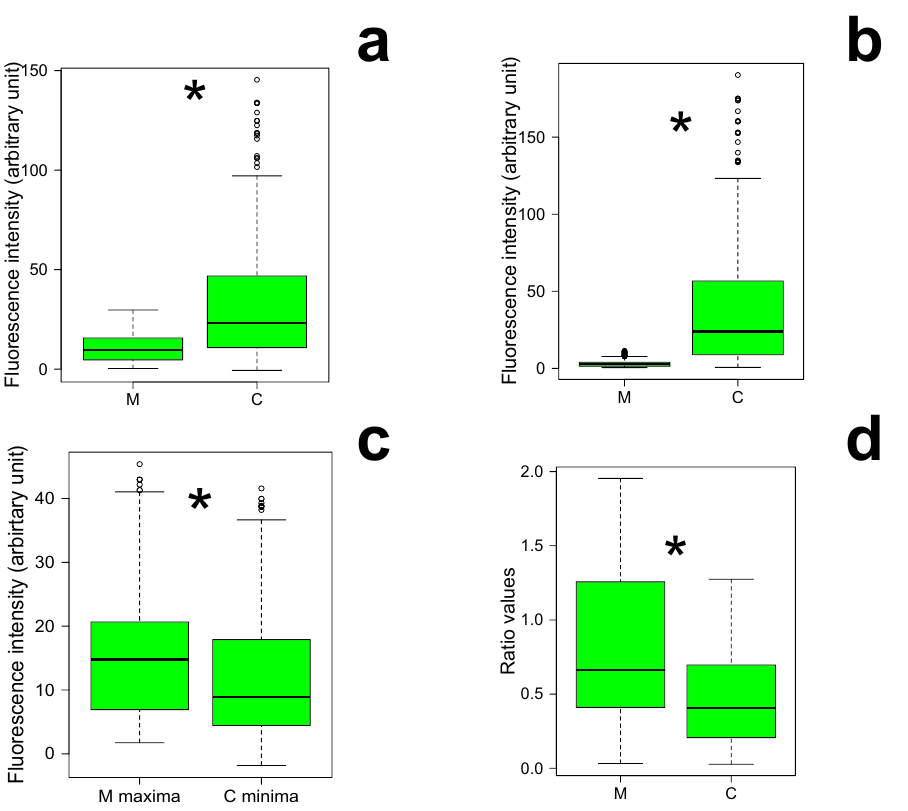
Figure 3. Boxplots of the fluorescence intensities of the EEM spectra of marked and control glass eels and their values of the selected fluorescence ratios. Boxplot of the fluorescence intensities ( a ) means, ( b ) standard deviations ( c ) maxima and minima measured whithin the bands of the alizarin peak (2) and ( d ) boxplot of the fluorescence ratio values that have been selected. M: marked group (n = 12). C: control group (n = 12). *: significant